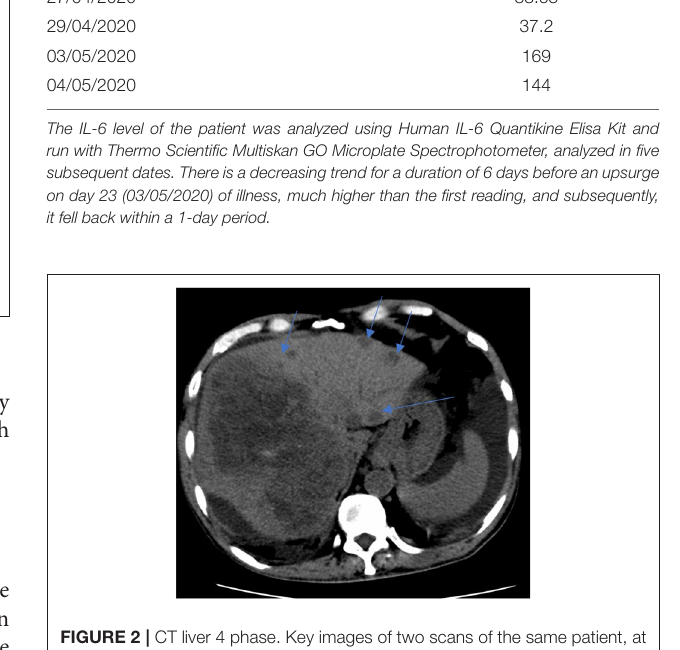
FIGURE 2 | CT liver 4 phase. Key images of two scans of the same patient, at the same slice taken 3 weeks apart. Subsequent CT shows enlarging right liver mass with multiple new left liver lobe lesions (multiple blue